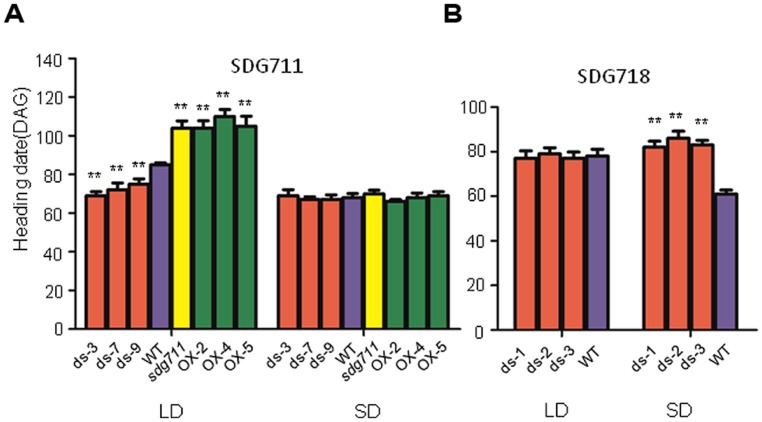
Flowering time of SDG711 and SDG718 transgenic plants. (A) Heading date (DAG: days after germination) of 3 SDG711 RNAi (ds) lines, three OX lines and the gain-of-function mutant (sdg711) compared to WT in LD and SD conditions. (B) Heading date of three SDG718 RNAi (ds) lines compared to WT in LD and SD conditions. Twenty plants per genotype were surveyed. Significance of differences between WT and transgenic plants are indicated by (∗∗p < 0.01, Student’s t-test).